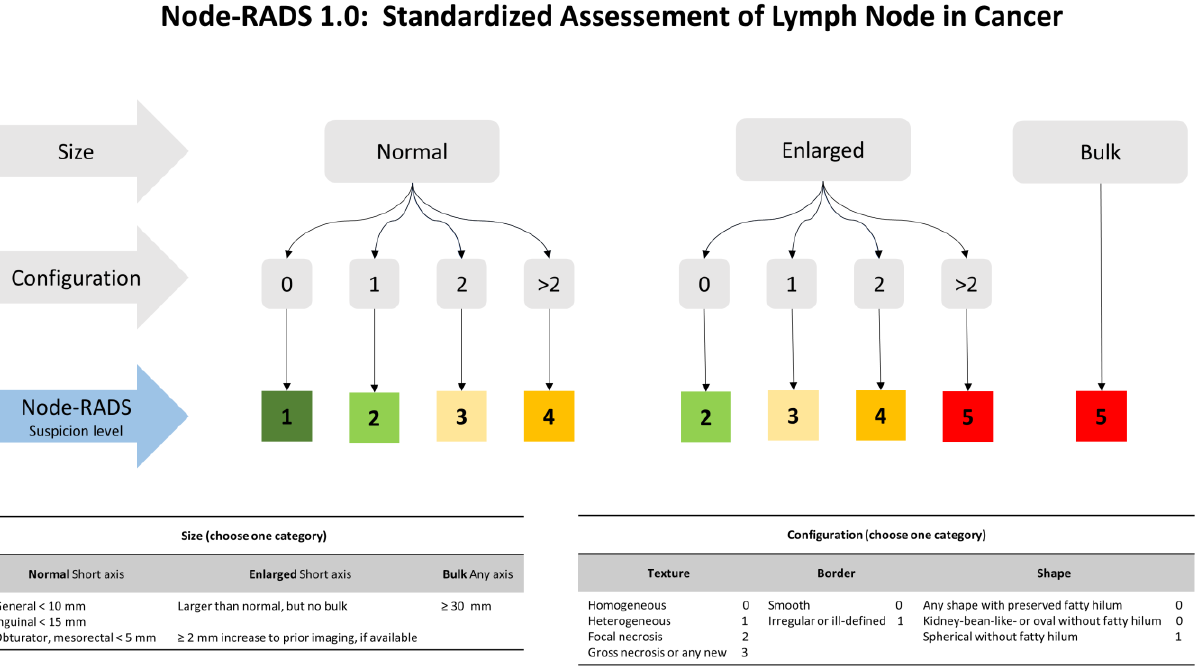
Figure 1. Explanation of the Node-RADS scoring system, adapted from the original publication